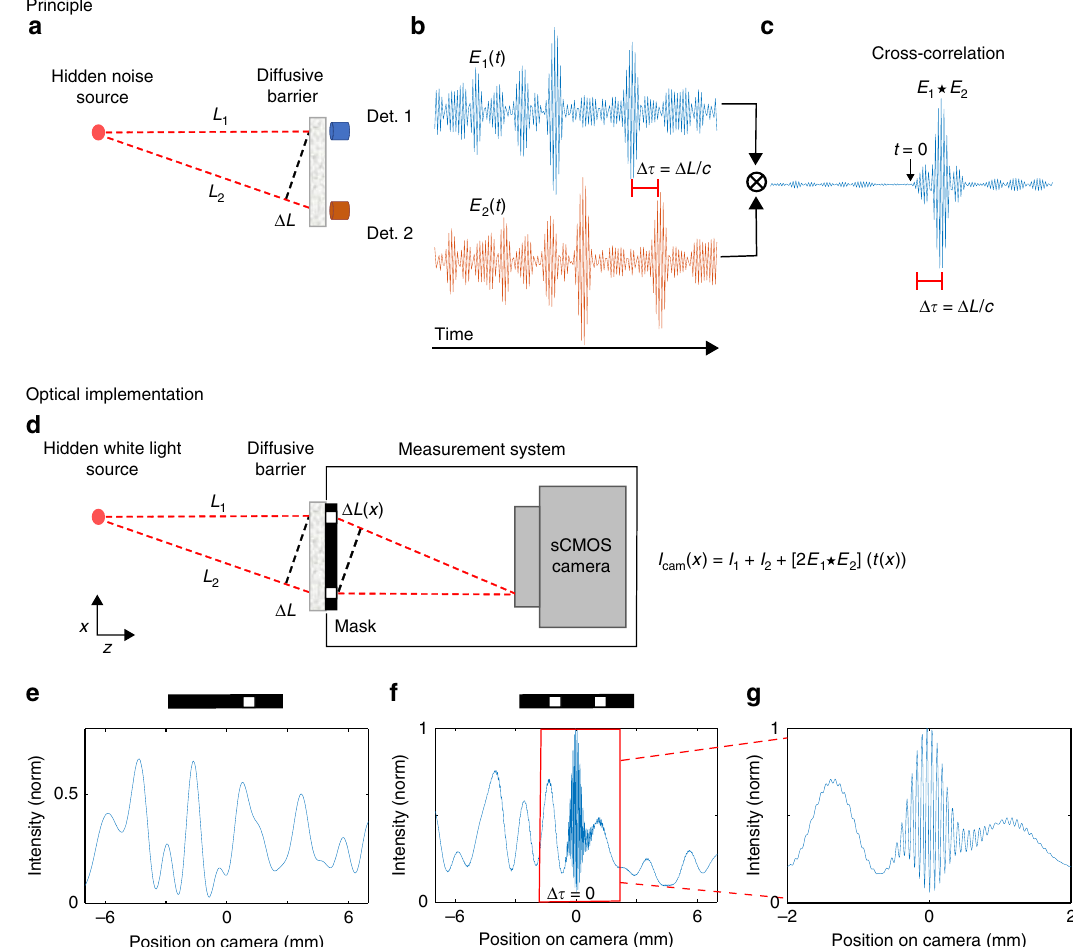
Fig. 1 Passive TOF by temporal cross-correlations. a – c Principle: a white-light source or a re fl ective object is hidden behind a diffusive barrier. a The random noise fi eld from the source is measured at two points on the barrier by detectors 1 (blue) and 2 (orange). b For a thin barrier, the measured fi elds are replicas of the same broadband noise, shifted by the time-of- fl ight (TOF) difference Δ τ = Δ L / c . c Cross-correlating the measured fi elds reveals the TOF difference as a sharp cross-correlation peak. d Optical implementation: light from two points on the barrier is selected by a controllable mask and interferes on a high-resolution camera. A single long-exposure camera shot I cam ( x ) provides the fi elds temporal cross-correlation at different time delays, t ( x ) = Δ L ( x )/ c . e – g Numerical example of the measured intensity patterns on a single camera row. e For a mask with a single aperture, a speckle intensity pattern is measured. f For a double-aperture mask, a cross-correlation peak appears as white-light interference fringes on top of the speckle pattern, providing the TOF difference Δ τ . g Zoom-in on ( f ), the TOF resolution is the source coherence